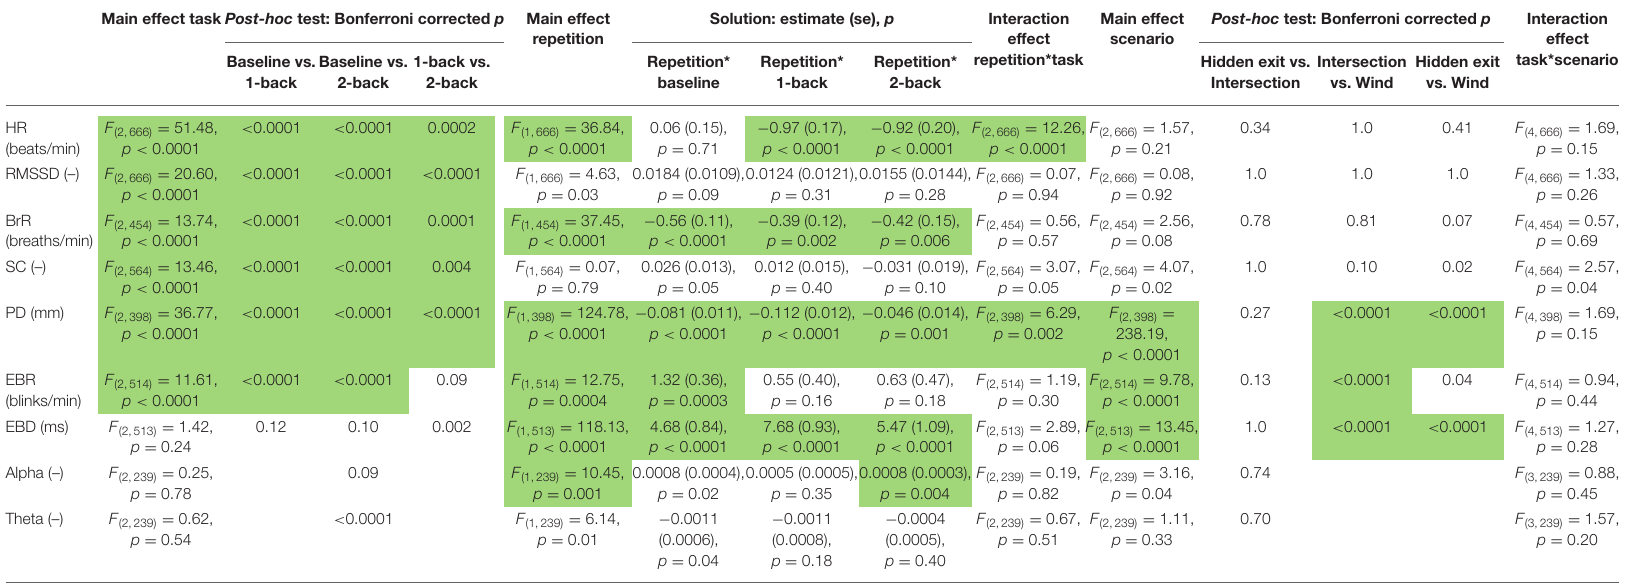
TABLE 3 | Results from Mixed Model ANOVAs of effects of task, repetition, and scenario for each measure. Main effect task Post-hoc test: Bonferroni corrected p Main effect